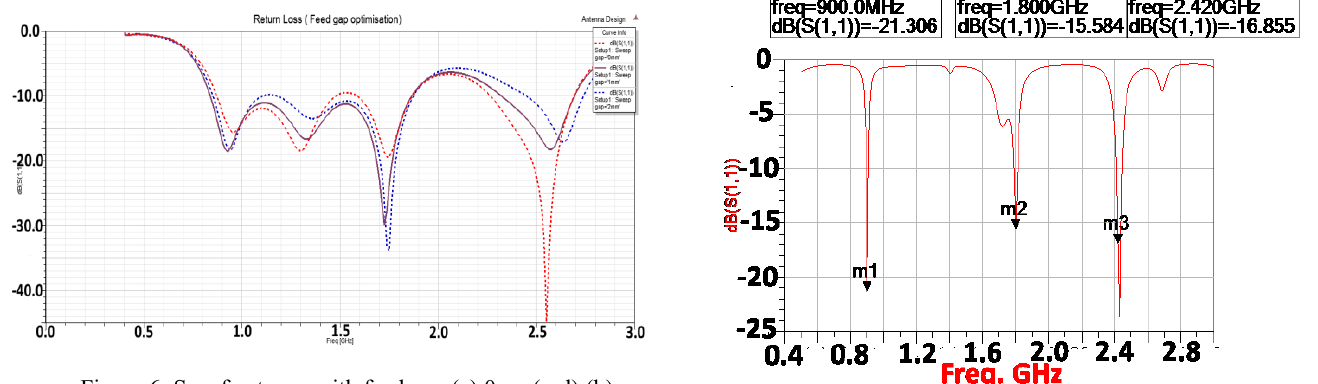
Figure 6: S of antenna with feed gap (a) 0mm(red) (b) 11 1mm(grey) (c) 2mm(blue)